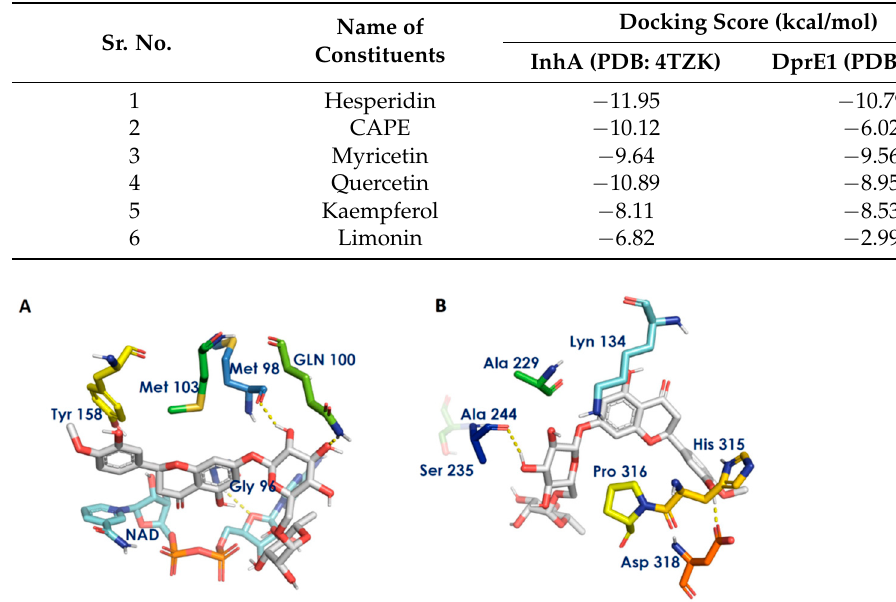
Table 2. In silico anti-tuberculosis potential of propolis constituents. Sr. No.